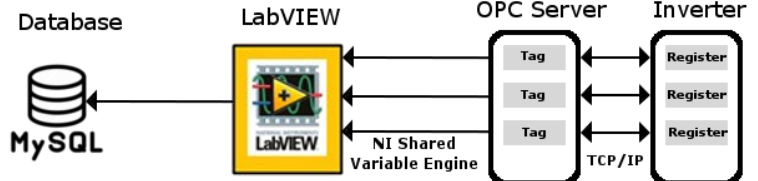
Figure 12. The software components of the monitoring system.